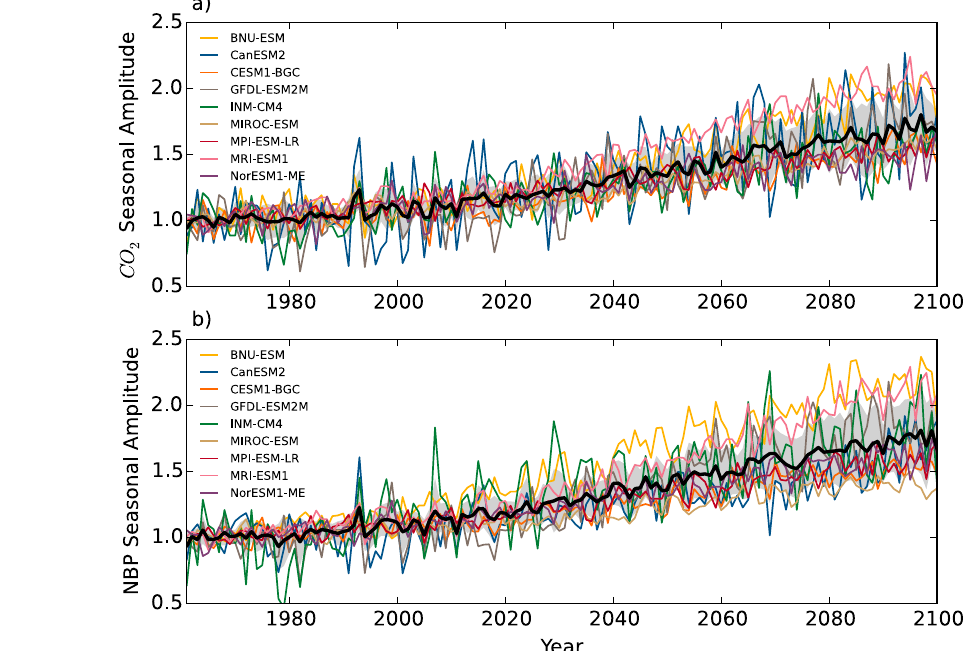
Figure 2. Time series of the relative seasonal amplitude (relative to 1961–1970 mean) of (a) global mean atmospheric CO 2 ; and (b) global total NBP from 1961 to 2099. Thick black line represents multi-model ensemble, and one standard deviation model spread is indicated by light grey shade.